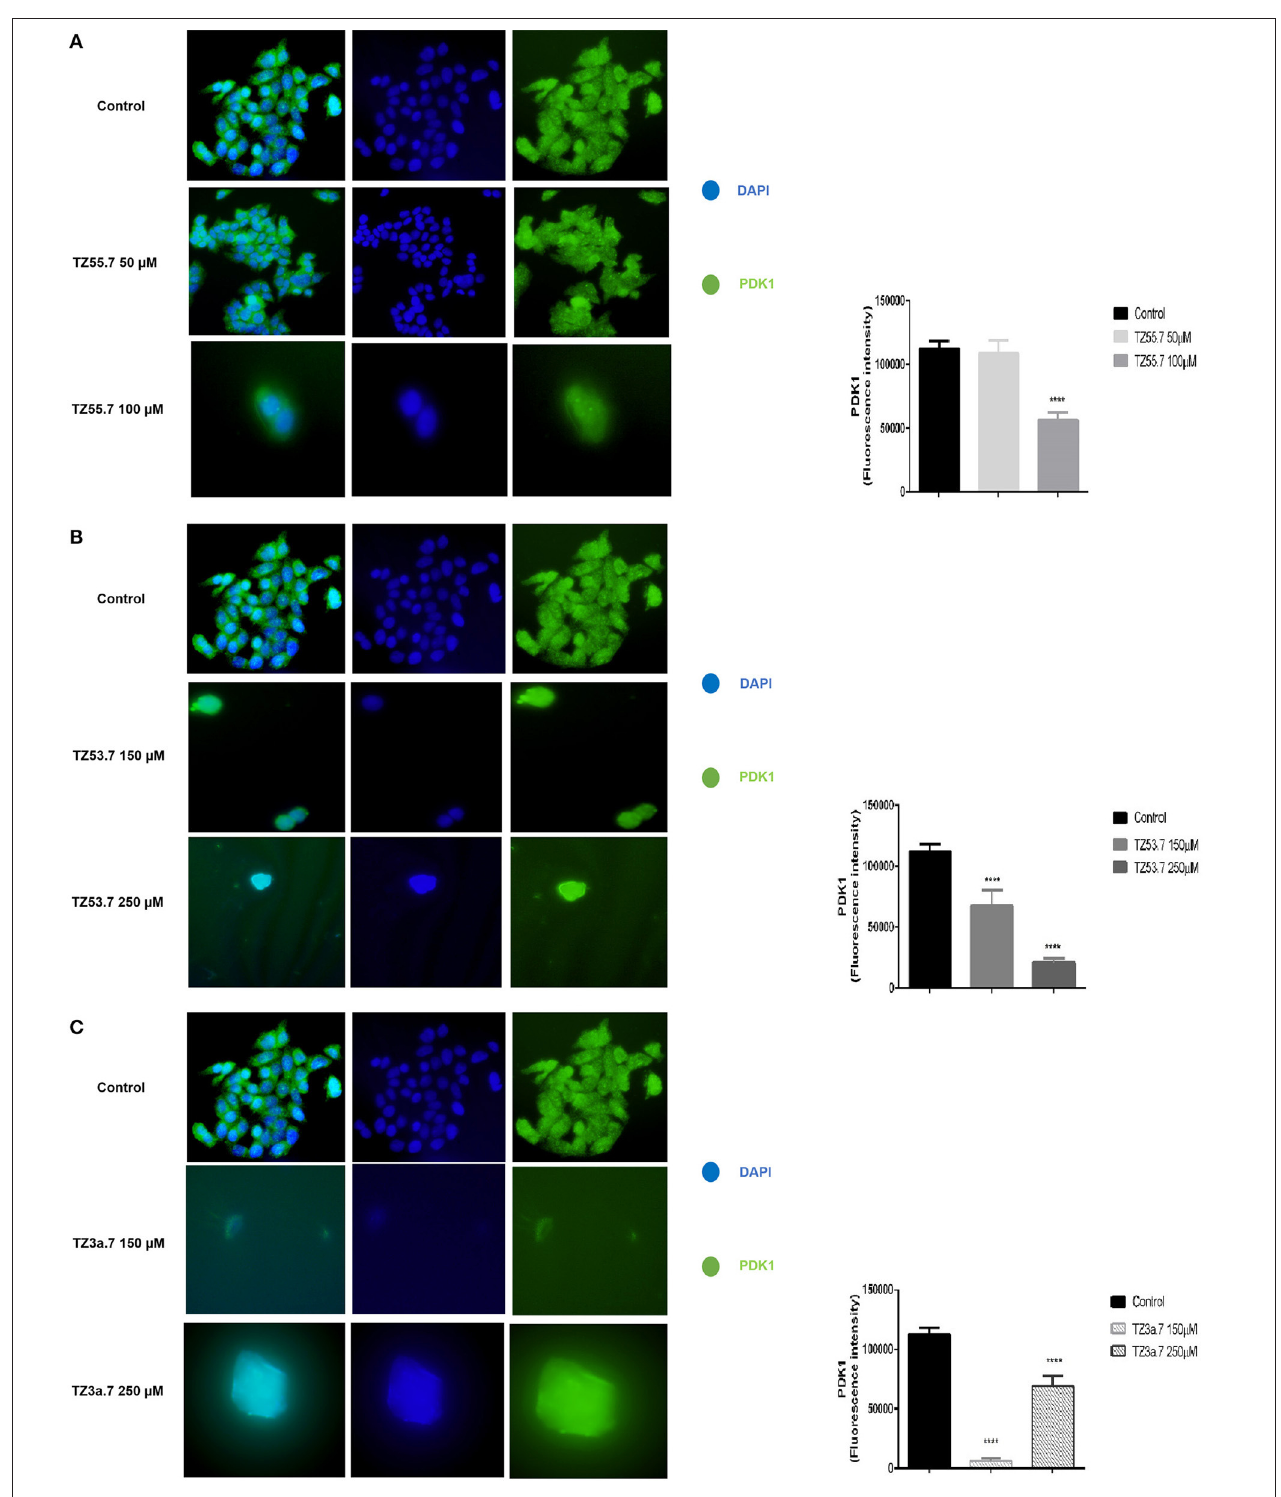
FIGURE 8 | Immunostaining of PDK1 expression in HT-29 cells stimulated with TZ55.7 (50 and 100 µ M) (A) , TZ53.7 (150 and 250 µ M) (B) , TZ3a.7 (150 and 250 µ M) (C) , for 24h compared to control cells (unstimulated cells). Quantification of the fluorescence intensity was assessed for five randomly selected areas using ImageJ software and is presented in graphical representation. The statistical significance was performed with One-way ANOVA using GraphPad Prism 6 software (**** p < 0.0001).